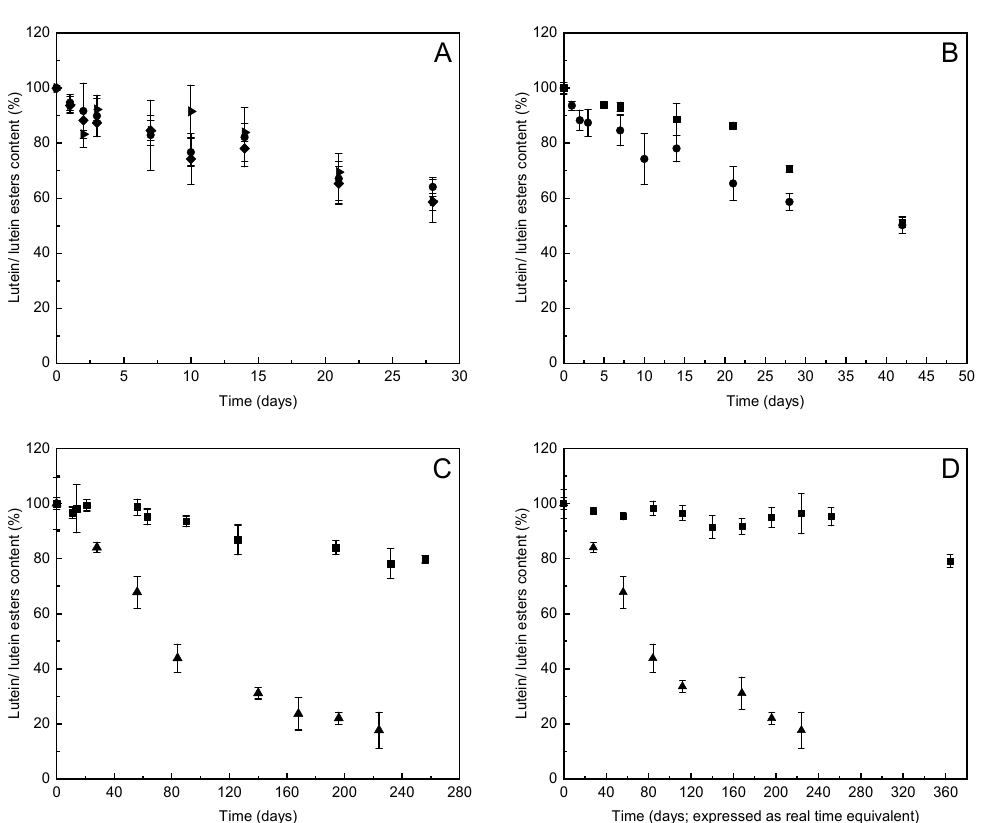
Figure 3. ( A ) Stabilities of formulation 3L (viscous emulsion) with lutein extract over 30 days under different storage conditions: In the light at 25 °C ( ► ); in the dark at 25 °C ( ♦ ); and in the dark at 4 °C ( ● ). ( B ) Stabilities of formulation 3L (viscous emulsion) with lutein over 42 days at 25 °C in the dark without ( ● ) and with ( ■ ) vitamin E. ( C , D ) Long-term stabilities of formulations 3L with lutein ( ▲ ) and 3LE with lutein esters ( ■ ) following real time at 25 °C in the dark ( C ) and accelerated conditions of storage at 37 °C in the dark ( D ). Time scale is calculated to real time. Data are means ± SD ( n = 3).